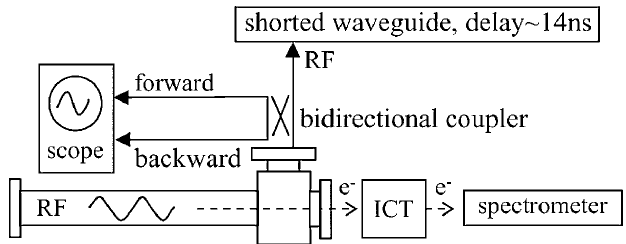
FIG. 12. (Color) Measured and simulated power generated vs